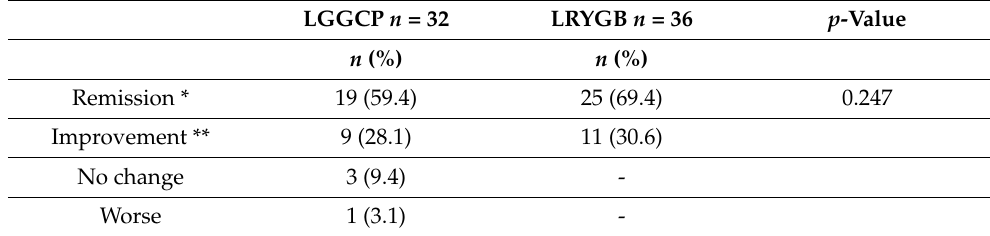
Table 3. Hypertension remission and improvement 3 year after operation.